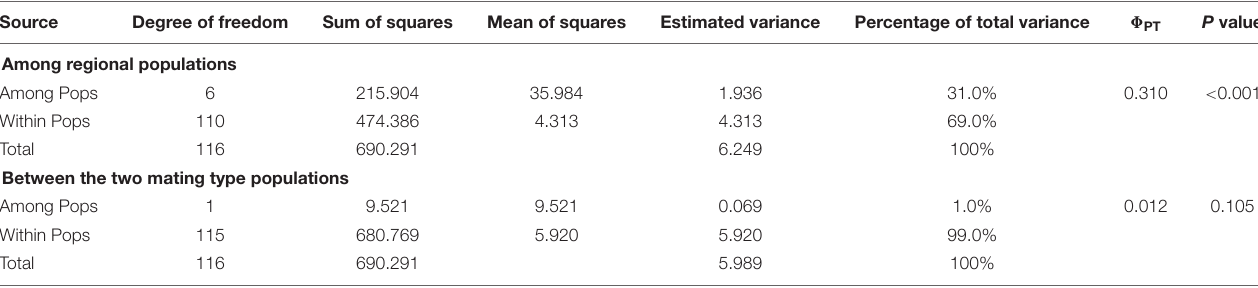
TABLE 5 | Analysis of molecular variance (AMOVA) among regional populations and between the two mating type populations of Setosphaeria turcica in Fujian Province, China, using inter-simple sequence repeat data. Source Degree of freedom Sum of squares Mean of squares Estimated variance Percentage of total variance (cid:56) PT P value